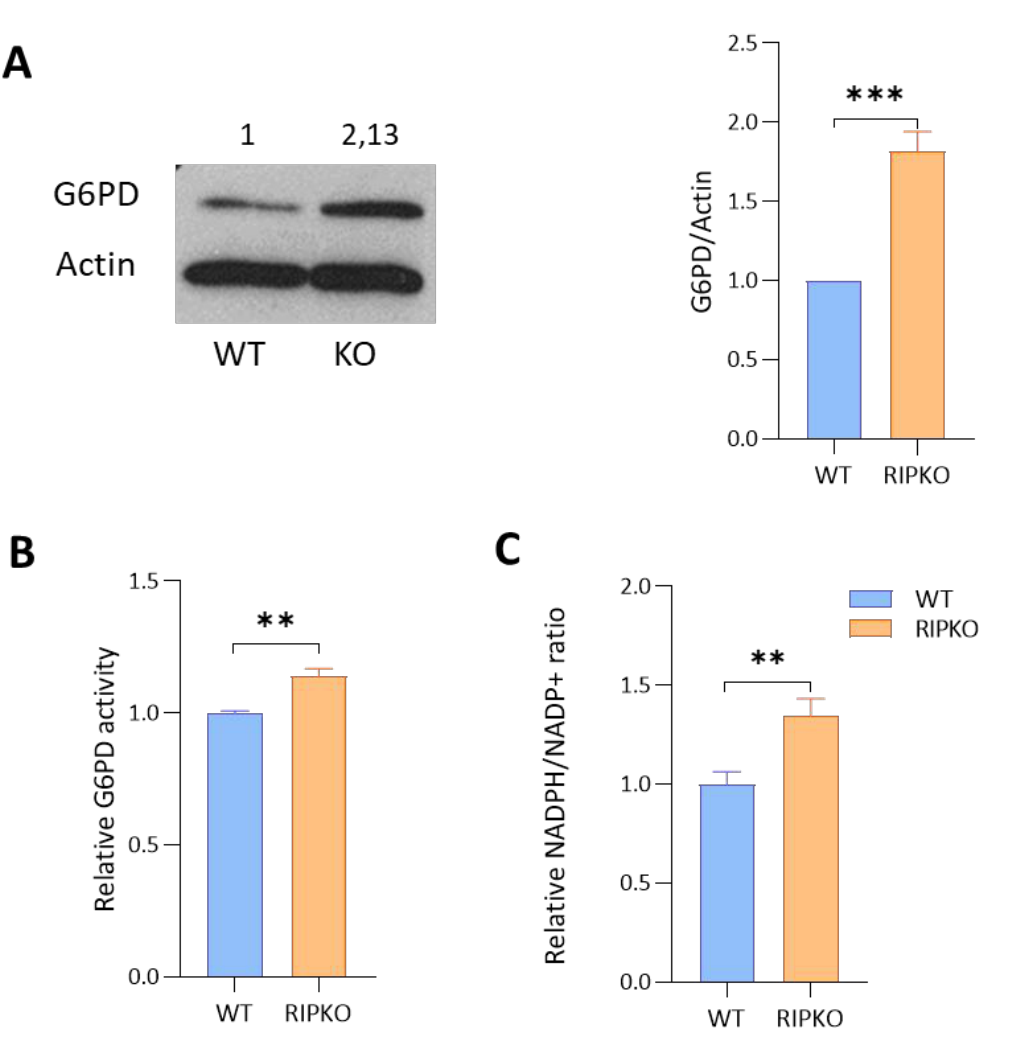
Figure 2. RIP140 deficiency increases G6PD activity. ( A ) The expression of G6PD and actin were assessed by Western blot analysis in WT or RIP140 knock-out (RIPKO) MEFs (left panel). Quantification was performed using Image J software on three independent experiments. Values were normalized to the actin signal and to WT samples (right panel). ( B ) The enzymatic activity of G6PD was quantified in WT or RIPKO MEFs using the G6PD assay kit (Sigma). Values are normalized to cell number and to WT samples. ( C ) The NADPH/NADP + ratio was quantified in WT or RIPKO MEFs using the Promega NADP/NADPH-Glo Assay. Data were normalized to protein concentration and to WT samples. All experiments were conducted at least three times. Values are means ± SEM; ** p < 0.01, *** p < 0.001.